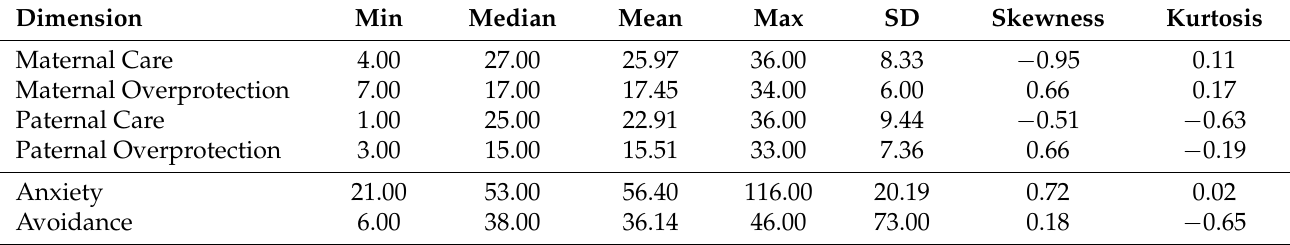
Table 1. Descriptive statistics for the distribution of each questionnaire’s subscale: Minimum (Min), Median, Mean, Maximum (Max), Standard Deviation (SD), Skewness and Kurtosis. Top section: PBI dimensions. Bottom section: ECR-R